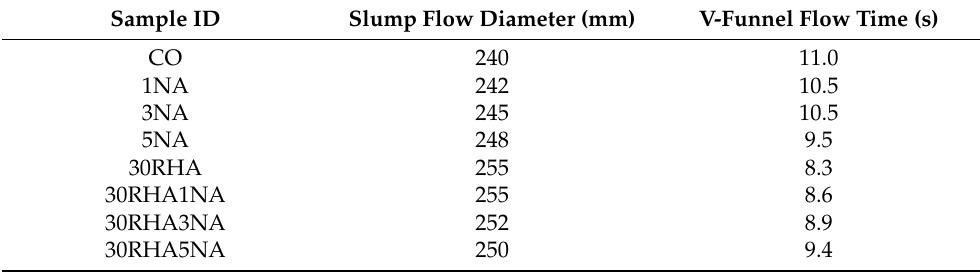
Table 4. Fresh properties of SC